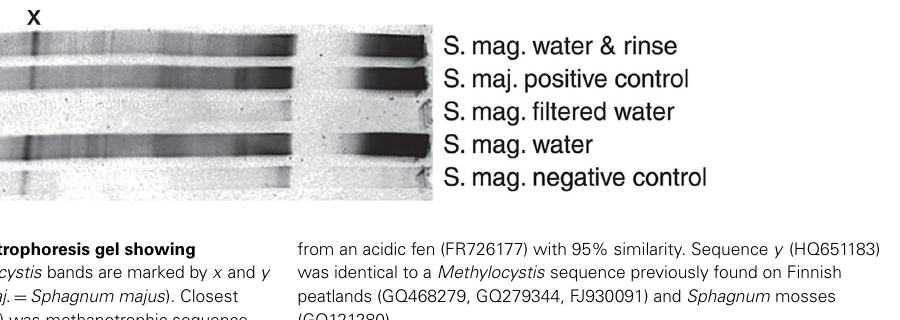
FIGURE 5 | Denaturing gradient gel electrophoresis gel showing differently treated samples. Two Methylocystis bands are marked by x and y ( S. mag. = Sphagnum magellanicum , S. maj. = Sphagnum majus ). Closest database match to sequence x (HQ651182) was methanotrophic sequence